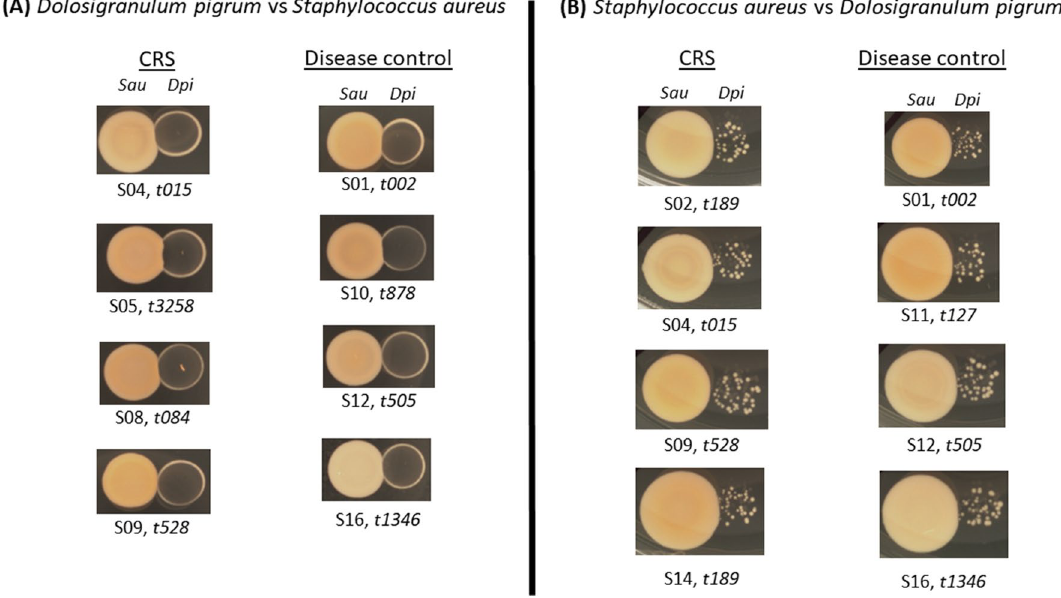
Figure 3. Dolosigranulum pigrum and Staphylococcus aureus co-culture assays on brain heart infusion (BHI) agar. Eighteen sinus-derived clinical isolates of S. aureus are ( A ) not inhibited by the pre-grown presence of D. pigrum , and ( B ) do not inhibit the growth of D. pigrum . Representative assays are shown for chronic rhinosinusitis and disease control S. aureus strains. D. pigrum was inoculated from BHI broth media onto BHI agar 2 days prior to inoculation of each S. aureus strain in ( A ). Each S. aureus strain was inoculated from BHI broth media onto BHI agar 1 day prior to inoculation with D. pigrum in ( B ). Co-culture assays